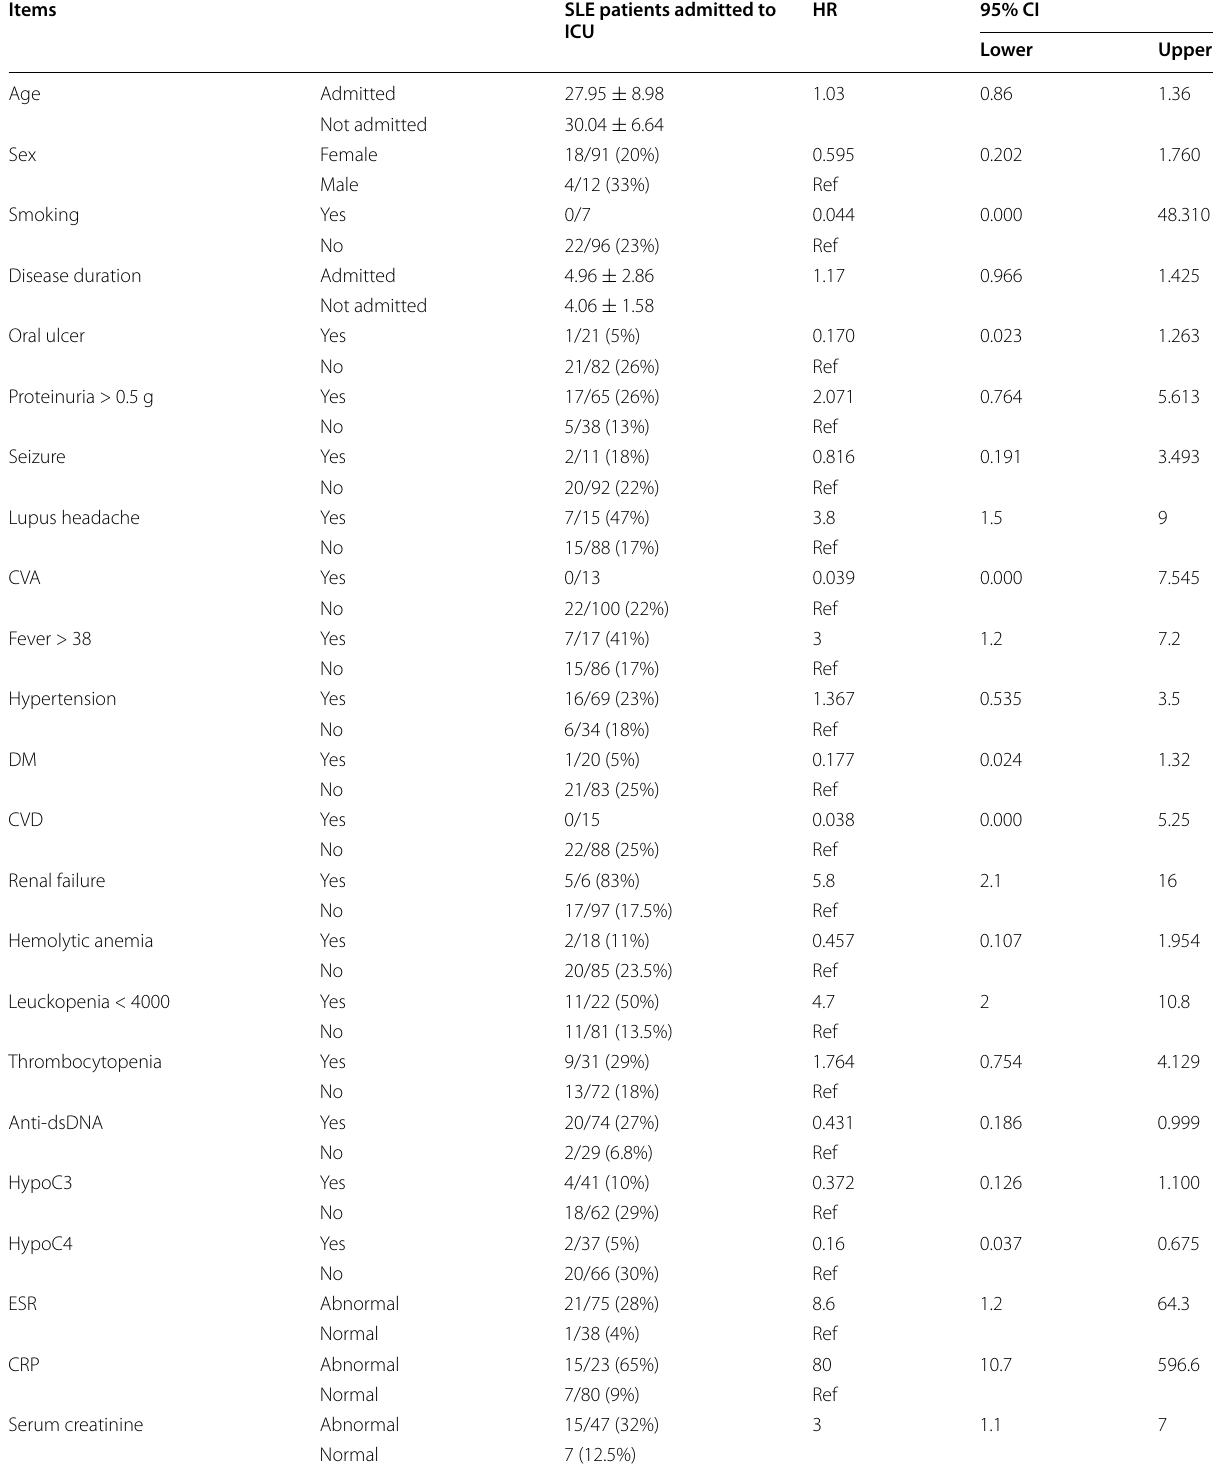
Table 3 Univariate Cox regression for demographic, clinical, and laboratory characteristics and type of treatment for SLE patients admitted to ICU during 1‑year